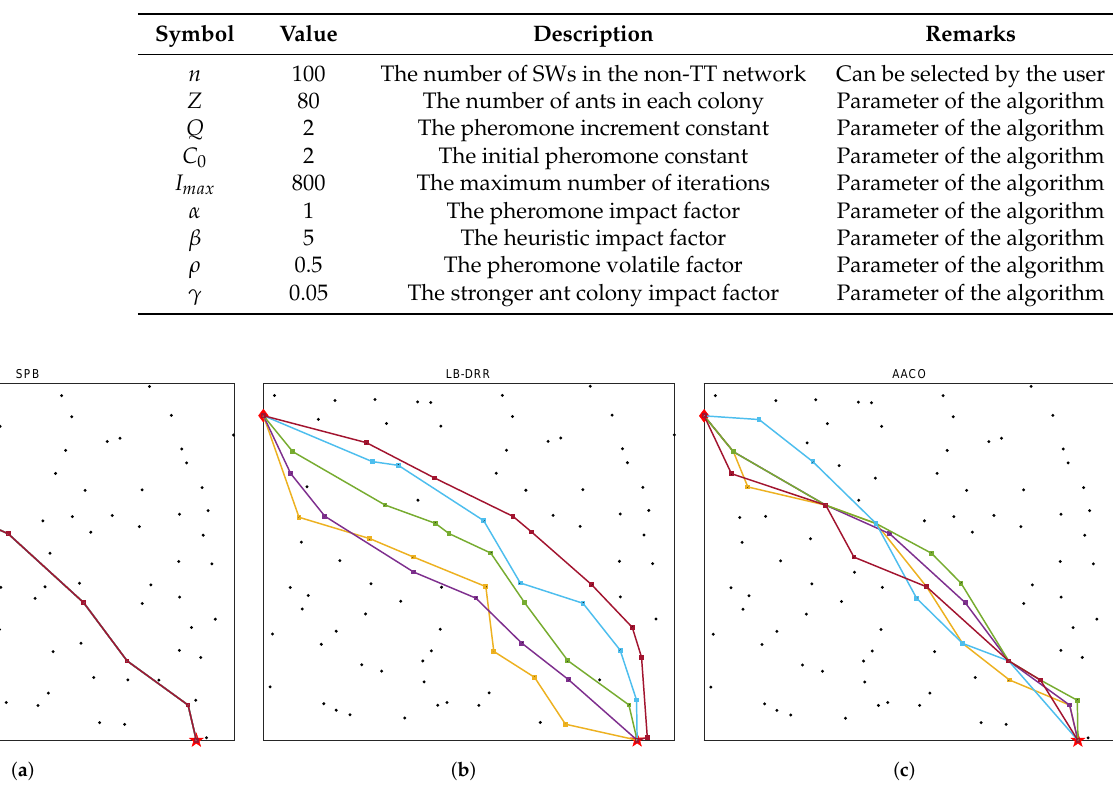
Table 3. The non-TT routing simulation parameters.